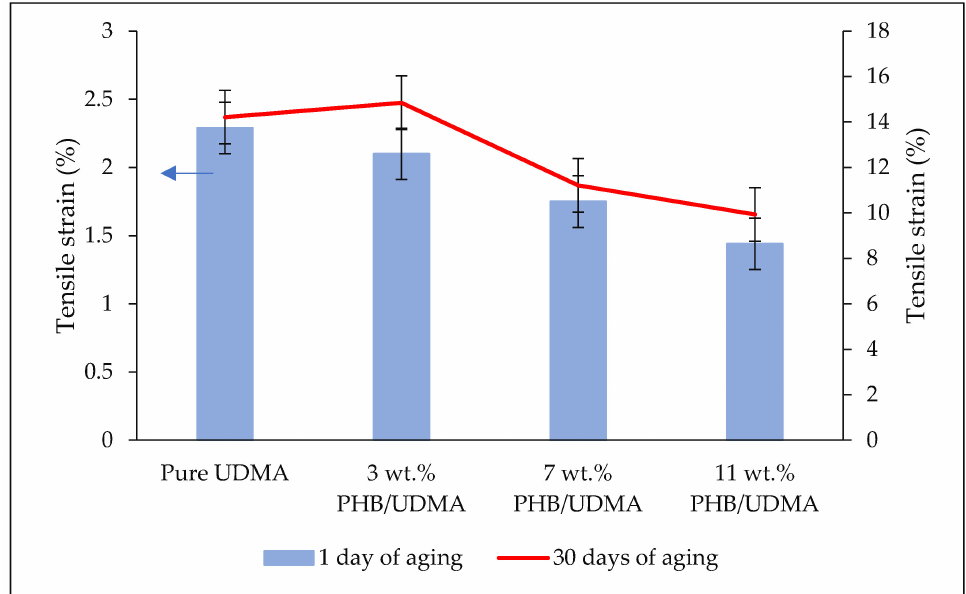
Figure 5. Comparative results of tensile strain of varied 3D printed PHB/UDMA after a day and a month of aging.